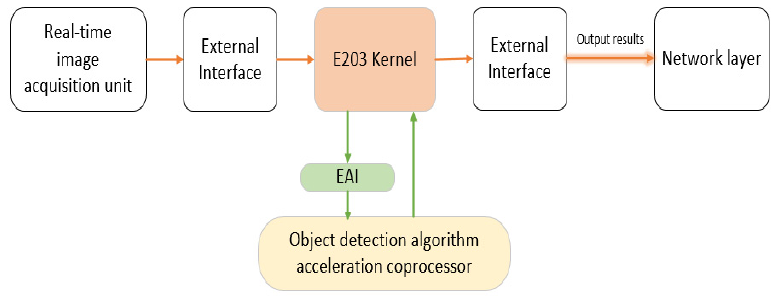
Figure 2. Data flow of the accelerator for object detection.